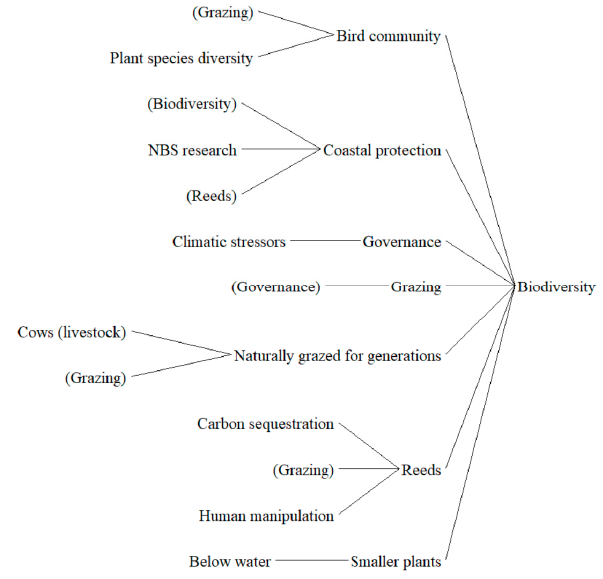
Figure 3. Vensim dendrogram highlighting the hierarchical network of stakeholder-identified ele- ments connected to the biodiversity of saltmarshes.